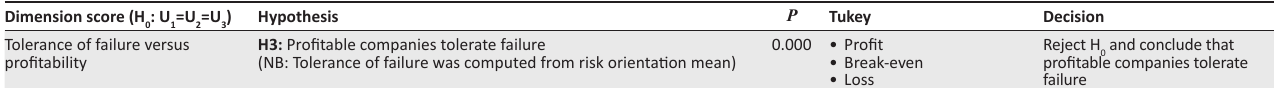
TABLE 5: Summary of analysis of variance tests on the dimensions of tolerance of failure versus profitability. Dimension score (H